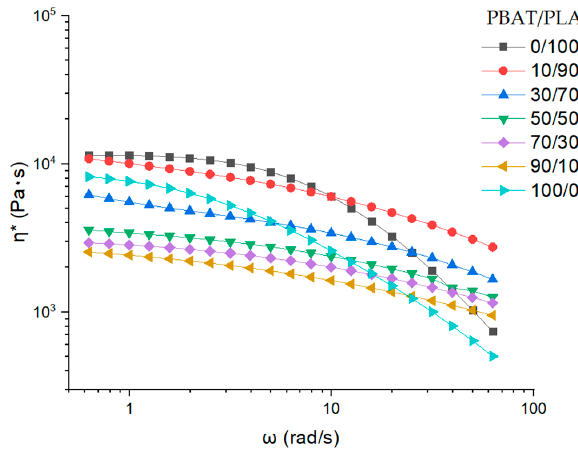
Figure 4. Angular frequency dependence of complex viscosity η *.